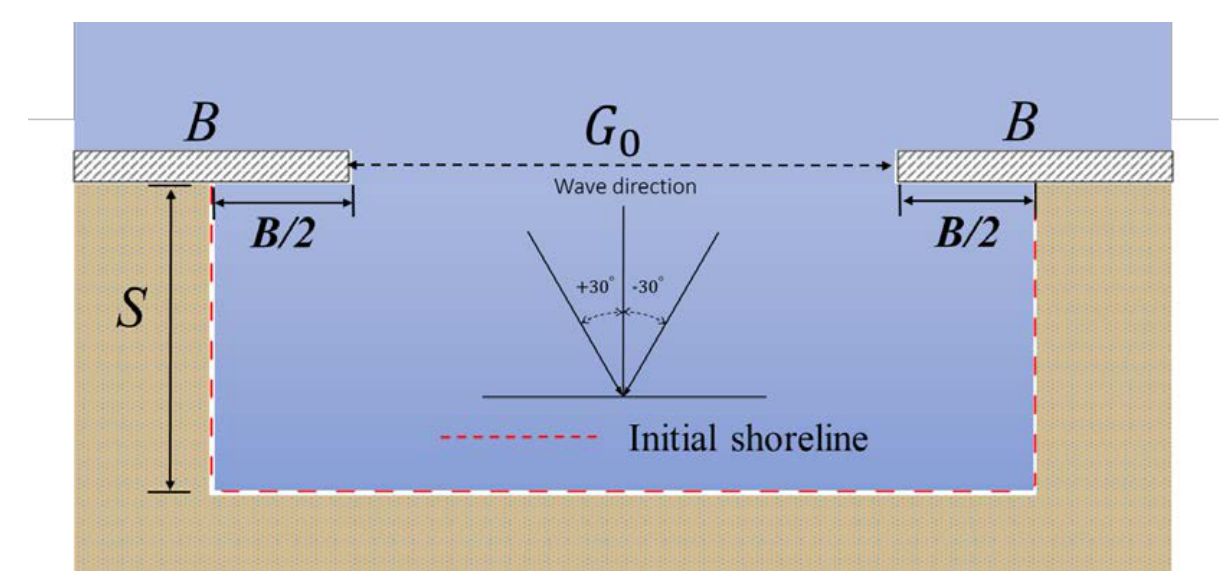
Figure 5. The setup of initial shoreline and two breakwaters (B = 60, S = 50, G 0 = 120, m ). In this test, the wave height of normal incidence is 1m and we adopted the EEMSE [29,30], which can account for a rapidly varying topography and wave energy dissipation in the surf zone, to calculate plane wave fields. the parameters are adopted in the following test: K 1 = 0.77, K 2 = 0.5 K 1 , D s = 10, ρ = 1033, ρ s = 2650, tan β = 1 , and λ = 0.43. In the 100 first test, three different time increments, ( ∆ t = 1, ∆ t = 0.1, ∆ t = 0.01, s ) , are used when m = 109 is adopted. The numerical results at t = 50 years are presented in Figure 6a and these three profiles of shoreline planform are almost identical to each other. The numerical comparison, provided in Figure 6a, can evidently verify the stability of the proposed